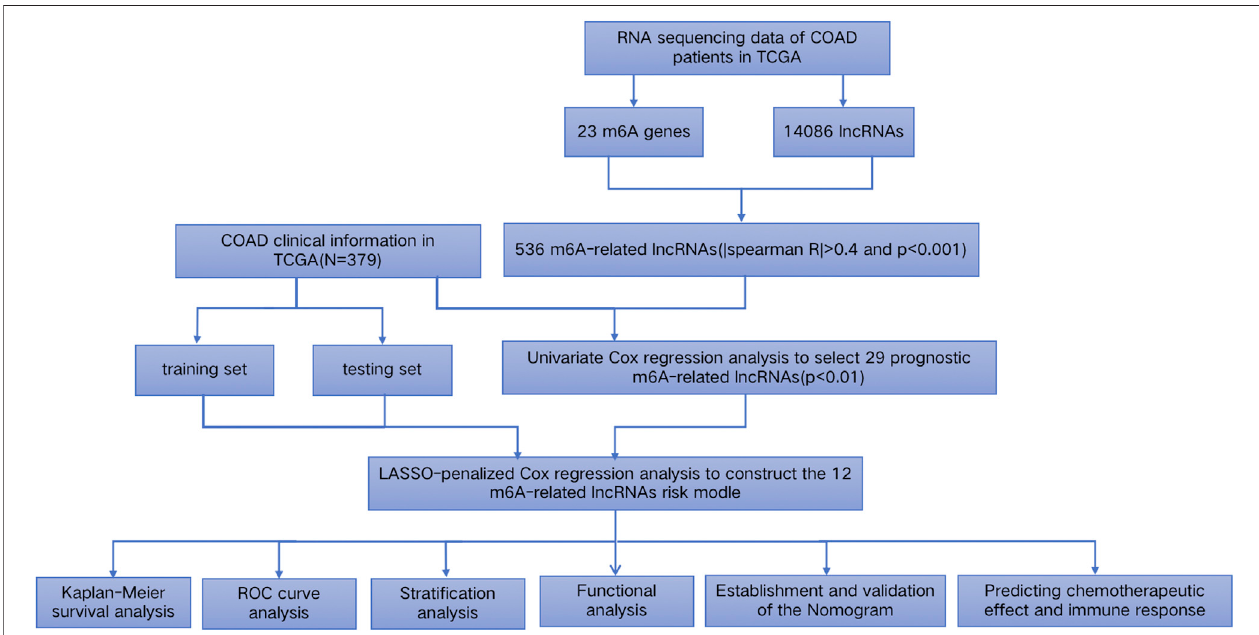
FIGURE1| Studywork fl ow.First,thesequencingdataandclinicalinformationofCOADpatientsamplesweredownloaded fromtheTCGAdatabase.Second,the expression data of23 m6A genes and 14,086 lncRNAs were extracted, and 536lncRNAs related tom6A were screened out via Spearman ’ s correlation analysis. Third, 379 patients with complete survival information were randomly grouped into a training dataset and a test dataset. Fourth, 29 prognostic m6A-related lncRNAs were identi fi ed through theunivariate CoxPHR analysisaccording tothe survivalinformation ofthe COADsamples. Then, the 29lncRNAs were applied toconstruct the 12 m6A-LPS. Finally, we performed the Kaplan – Meier survival analysis, ROC curve analysis, strati fi cation analysis, and functional analysis, established and validated the nomogram, and predicted the chemotherapeutic effect and immune response of the high- and low-risk groups.